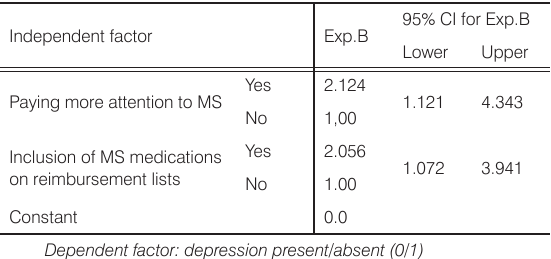
Table 5. Multiple logistic regression analysis of independent factors associated with depression. Independent